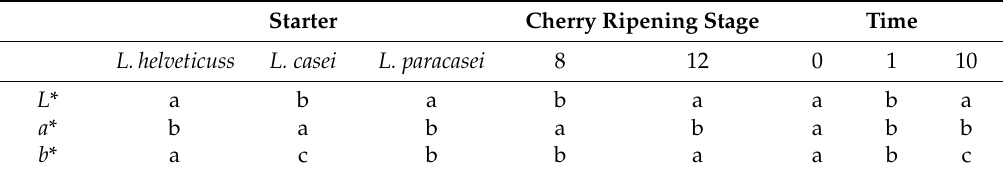
Different letters in the same row are indicative of significant differences ( p < 0.05) among mean values, with “a” being the lowest value and increasing according to alphabetical order. L * (lightness), a * (green-red coordinate) and b * (blue-yellow